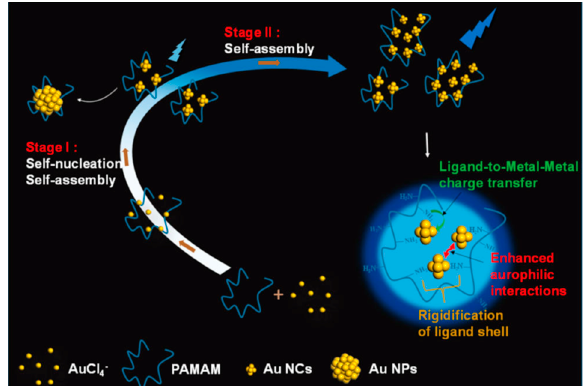
Figure 3. Schematic illustration of growth process and the morphology of Au 5 self-assemblies in poly(amidoamine) (PAMAM) matrix. Adapted with permission from Ref. [32]. Copyright (2018) American Chemical Society.